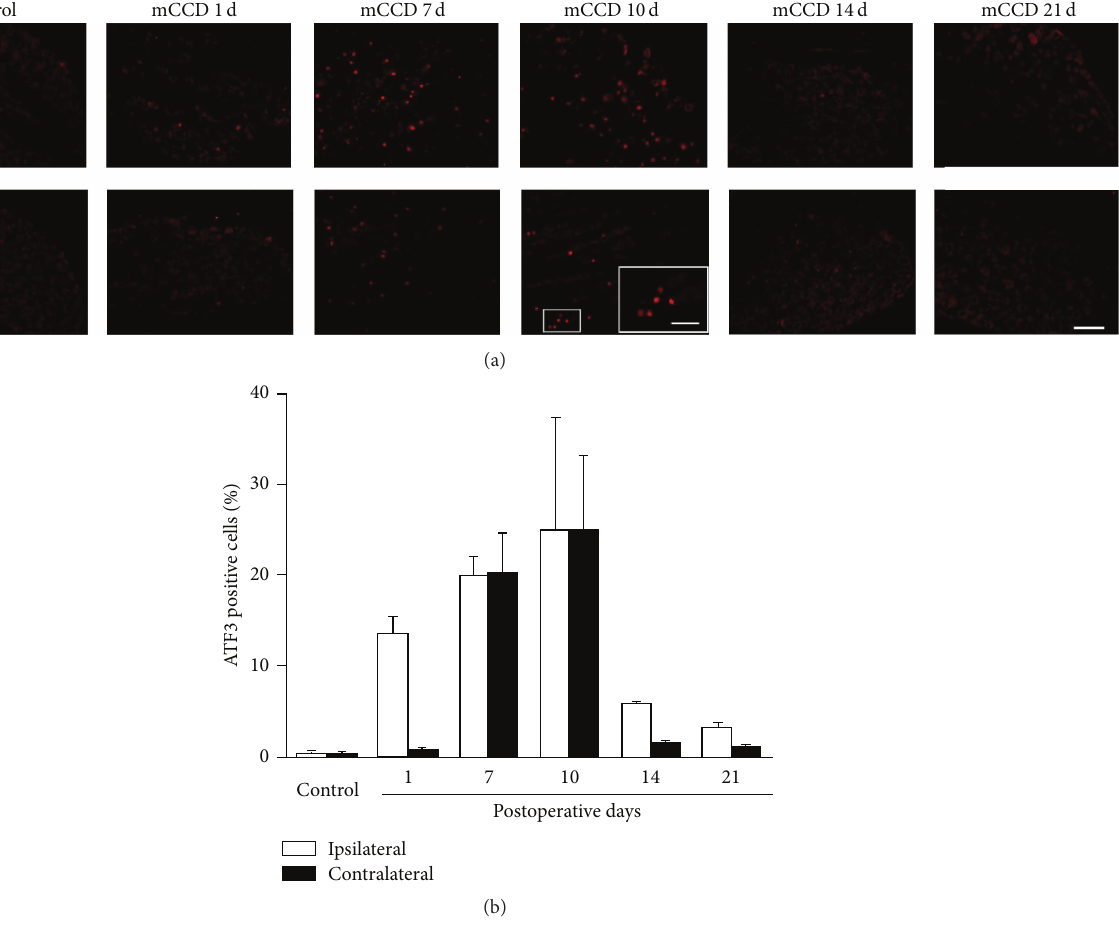
Figure 5: ATF3 expression was markedly increased in both ipsilateral and contralateral DRG neurons following the mCCD. (a) ATF3 expression in ipsilateral and contralateral DRGs in control and mCCD rats on 1st, 7th, 10th, 14th, and 21st postoperative days (inset: higher magnification, scale bar = 20 𝜇 m). (b) Percentage of ATF3 positive cells in ipsilateral and contralateral DRGs following the multiple DRG compression. Scale bar = 50 𝜇 m. Bonferroni test, 𝑃 s < 0.001 , compared to the bilateral DRG neurons of control